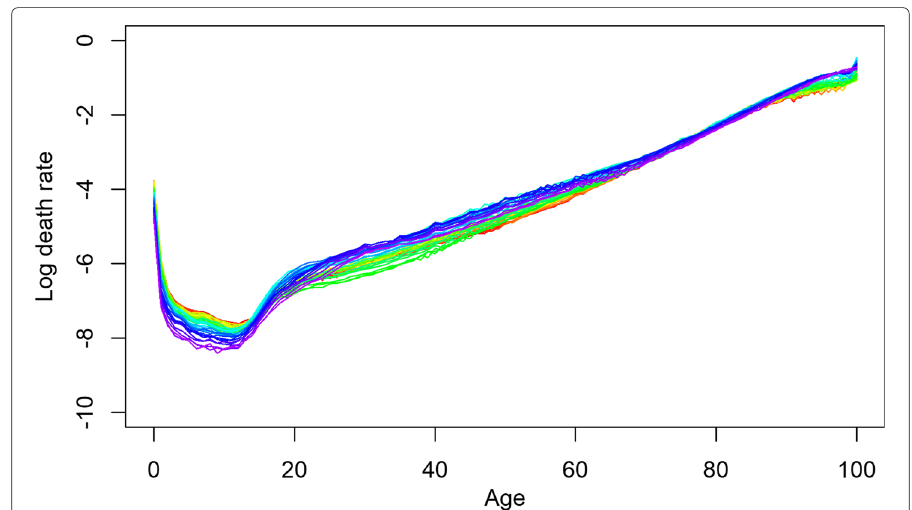
Fig. 7 Observed log mortality rates for combined mortality data of (comparatively) high mortality countries. Years are plotted using a rainbow palette so the earlier years are shown in red, followed by orange, yellow, green, blue, and indigo with the most recent years plotted in violet. Mortality crisis in recent period is more visible than previous trend specially for adult and later senescence age groups